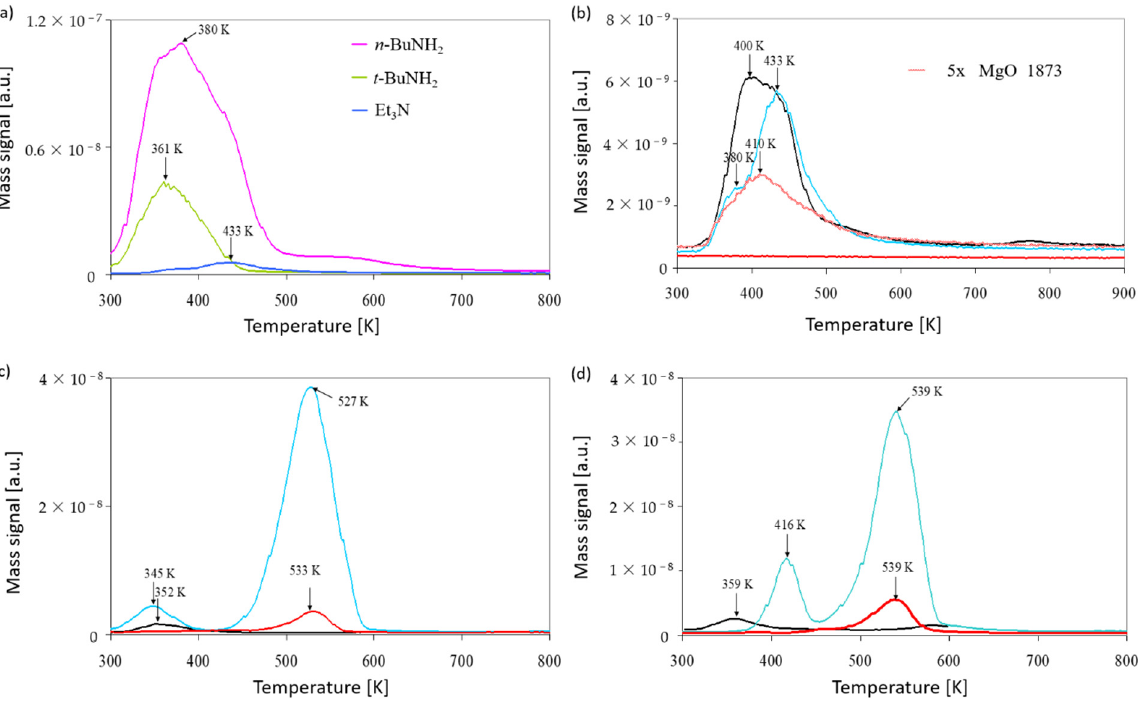
Figure 4. TPD results: profiles obtained for ( a ) MgO-873 using n -butylamine, t -butylamine and triethylamine as probe molecules, ( b ) triethylamine for different MgO-T samples, ( c ) pivalonitrile, and ( d ) acetonitrile; MgO calcined at 473 K (black), 873 K (blue), 1873 K (red).